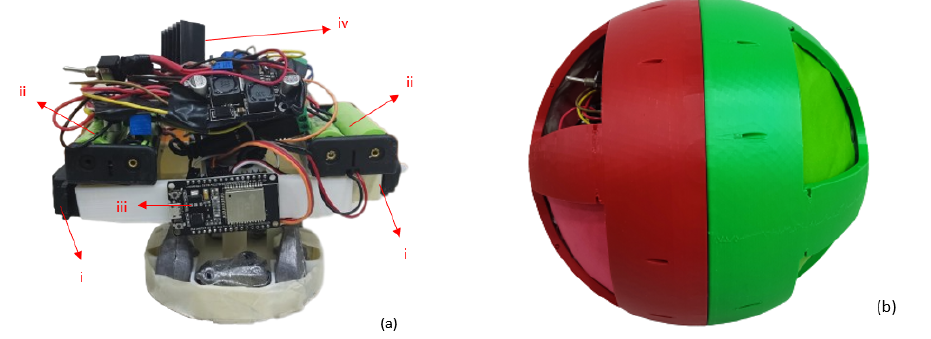
Figure 3. ( a ) Component locations: ( i ) 360° Servomotors. ( ii ) Batteries 18560. ( iii ) ESP32 micro- controller. ( iv ) Other components. ( b ) Spherical